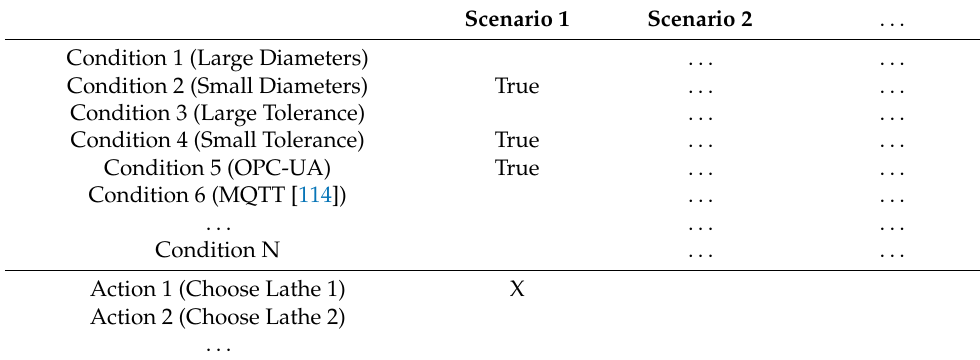
Table 2. Augmented decision table for technology-enhanced computer-aided process planning